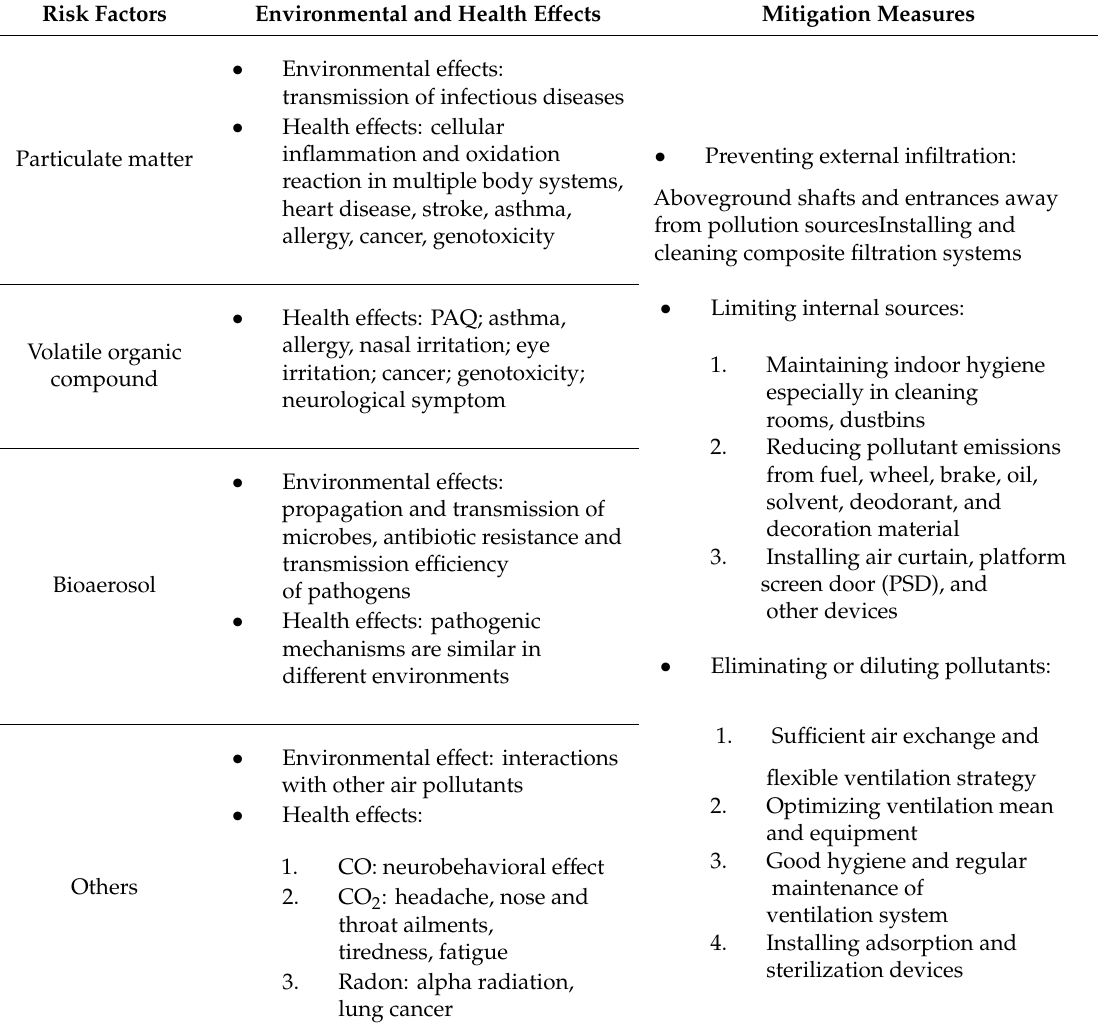
Table 2. Indoor air